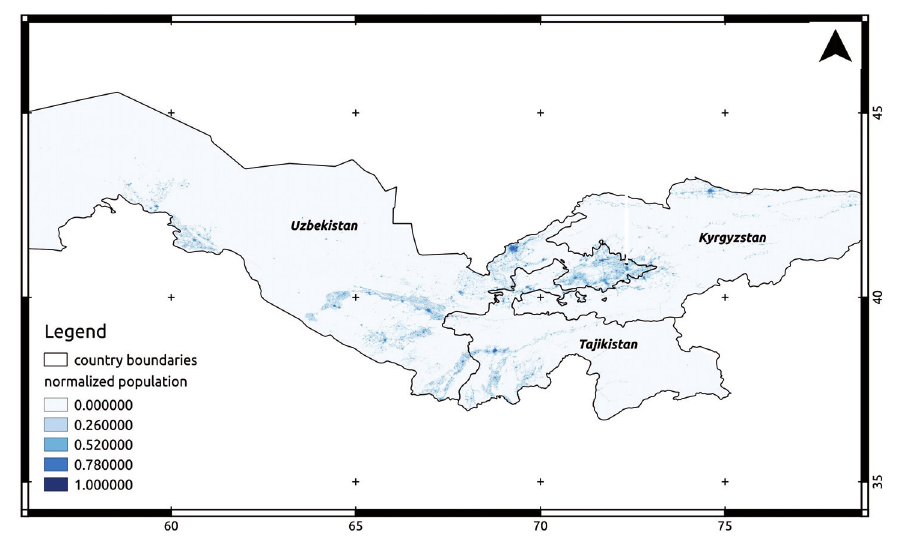
Figure 9. Normalized distribution of inhabitants in the selected region, including the Central Asian countries Kyrgyzstan, Tajikistan and Uzbekistan.